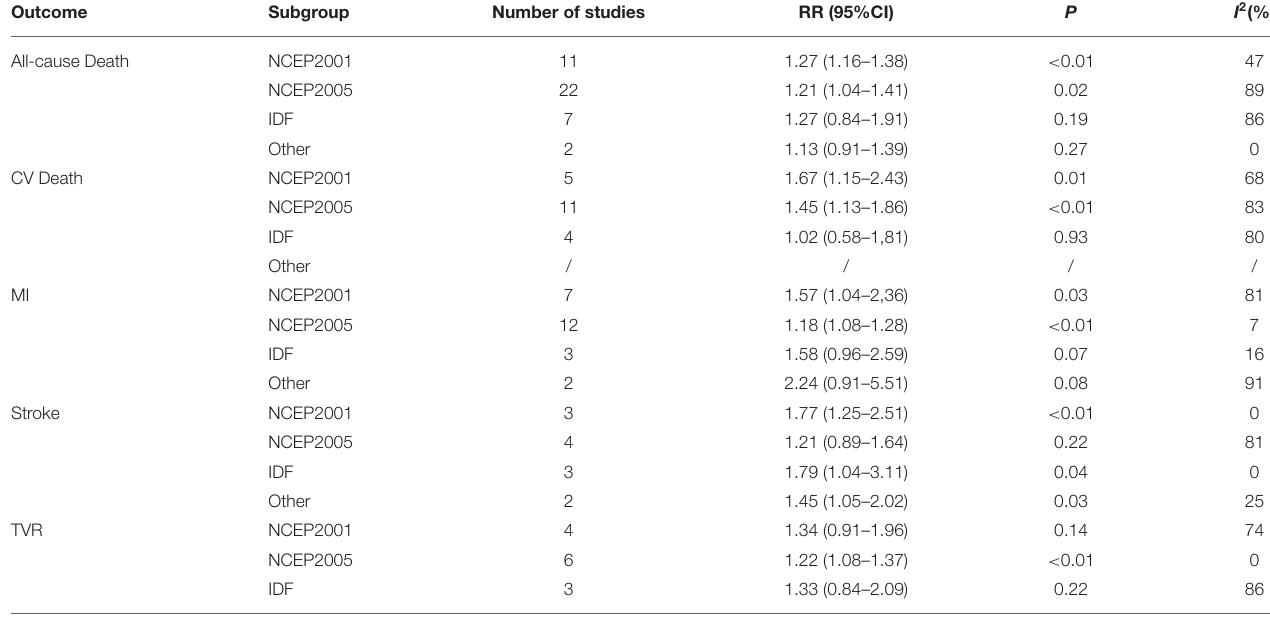
TABLE 3 | The results of subgroup analysis based on diagnostic criteria.